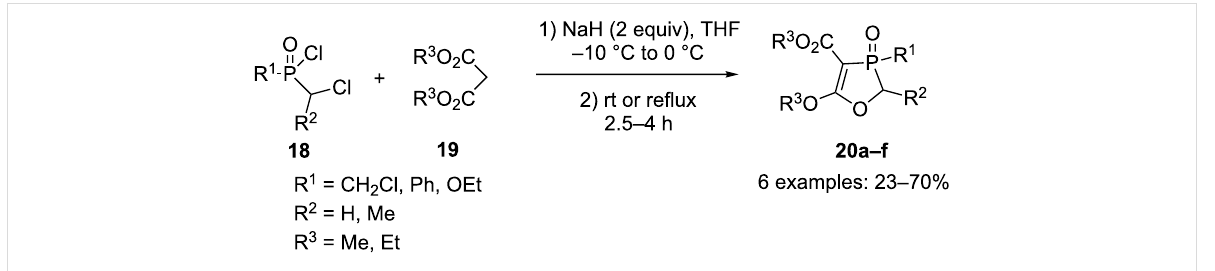
Scheme 9: Cyclization through phosphinylation/alkylation of malonate